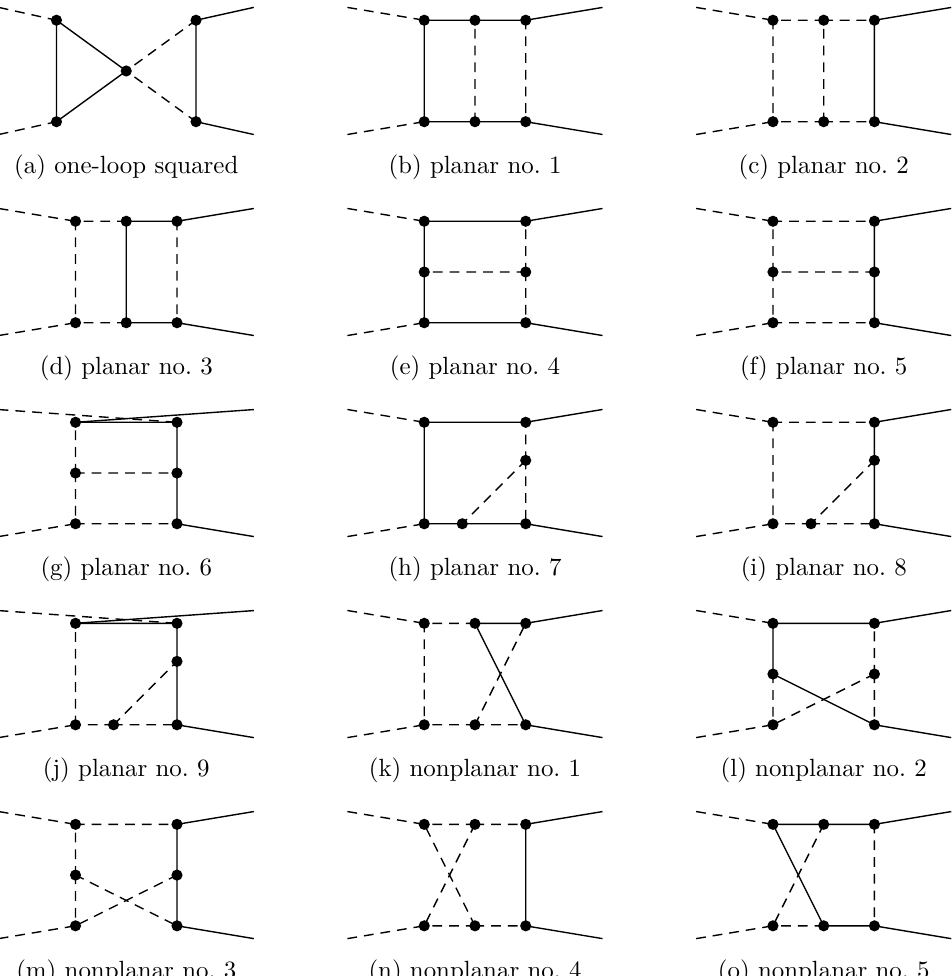
Figure 3. Topologies of integral families. Solid and dashed lines correspond to massive and massless particles respectively. Internal massive particles have mass m t while external massive particles have mass m W . All nine planar topologies and nonplanar no. 2 and 3 can be crossed ( p 1 ↔ p 2 ) giving a total of 26